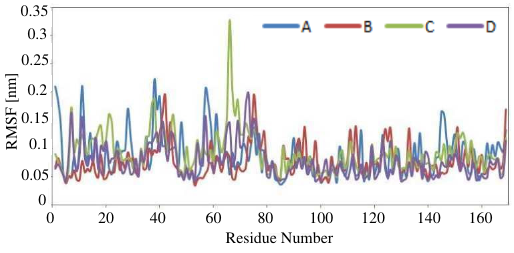
Figure 4: Average RMSF values for each residue of Flavodoxin during simulation in A , B , C and D sys-